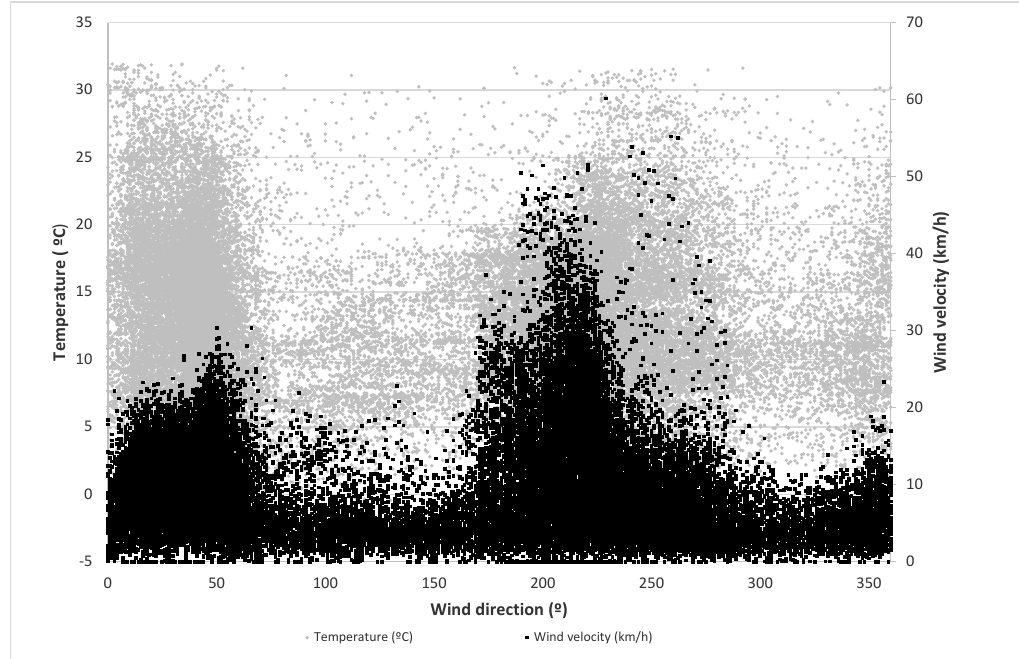
Figure 1. Temperature and air velocity for each wind direction.